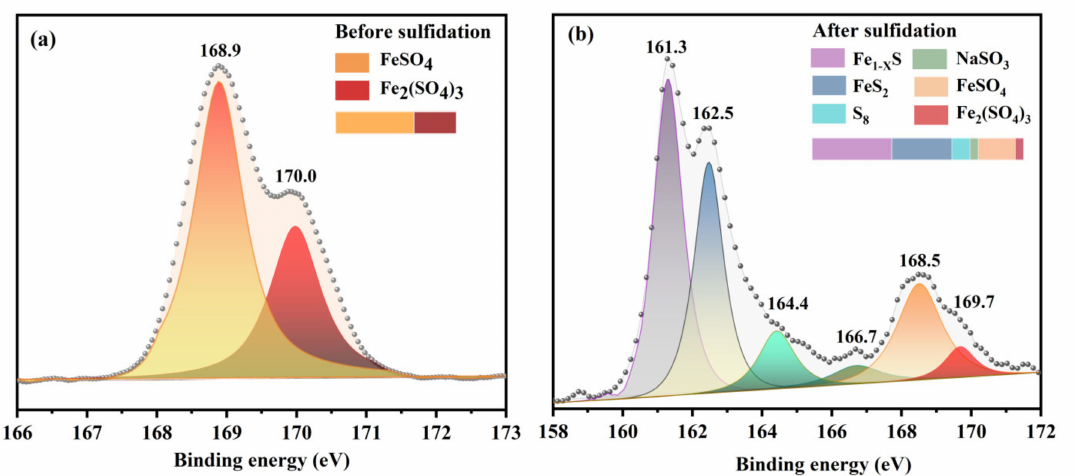
Figure 6. XPS spectra of S 2p for jarosite residues before ( a ) and after ( b ) sulfidation reaction (sulfidation conditions: 575 ◦ C, 1.5 h, 20 mL/min, 3% H 2 S and 97% N 2 balance